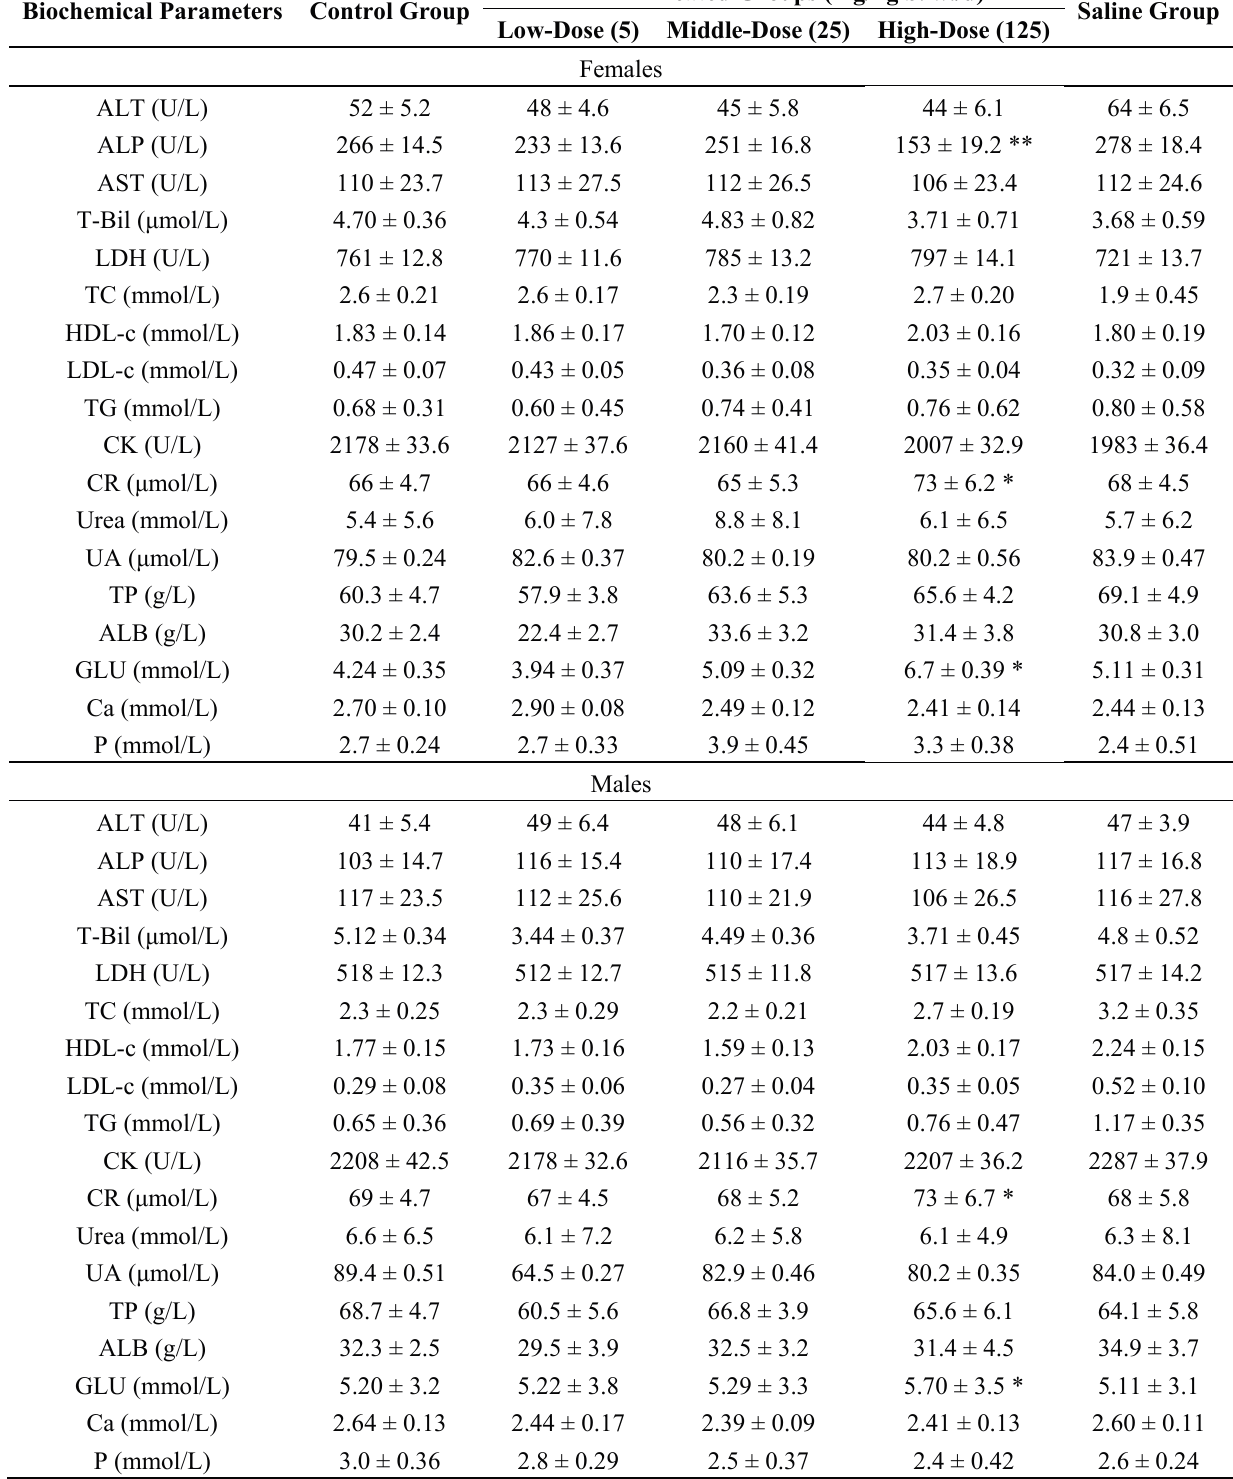
Table 5. Blood biochemical parameters of rats orally administered ATTM for 28 days. Biochemical